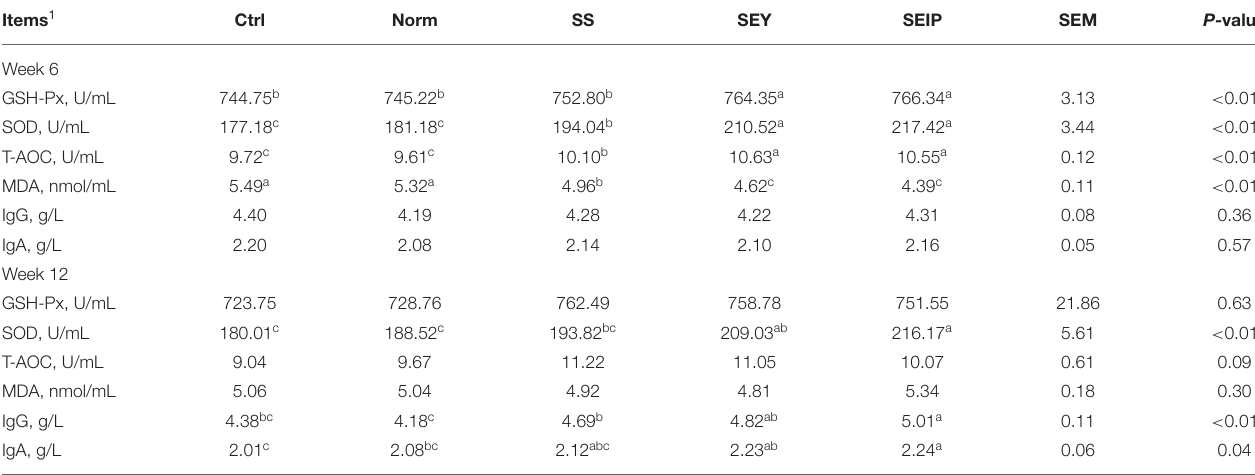
TABLE 6 | Effects of dietary Se sources on serum antioxidant and immune capacity of laying hens. Items 1